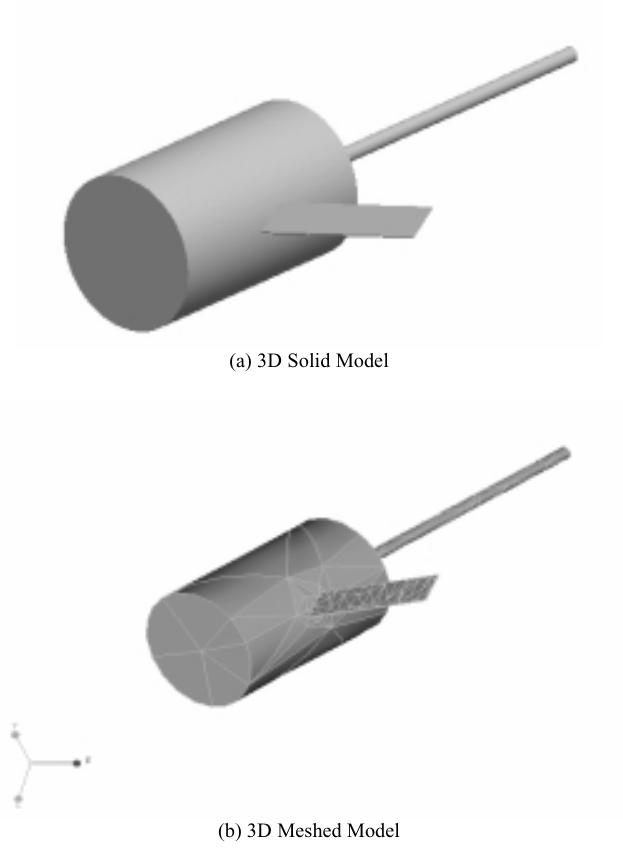
Fig. 8. 3D Solid and Meshed Models using Pro Mechanica FE